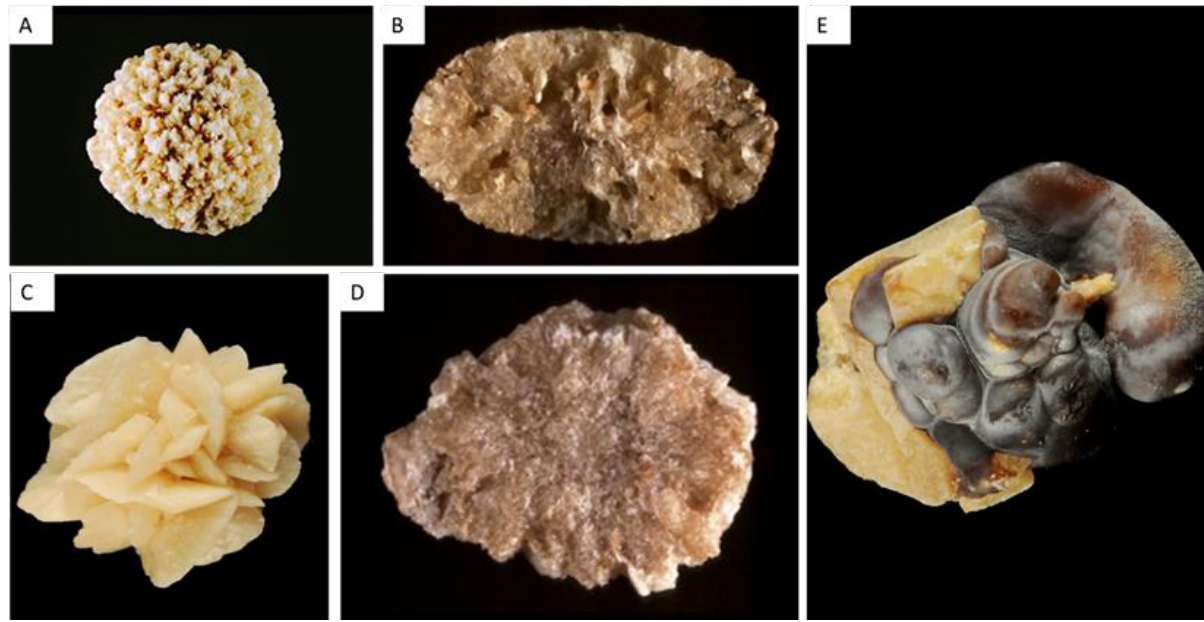
Figure 2. Type II stones, made of calcium oxalate dihydrate (and monohydrate if conversion occurs). ( A ) Type IIa stone with a typical sharp aspect. ( B ) Type IIa stone section, poorly organized. ( C ) Type IIb stone, with less sharp crystallites than type IIa. ( D ) Type IIb stone section. ( E ) Mixed type Ia